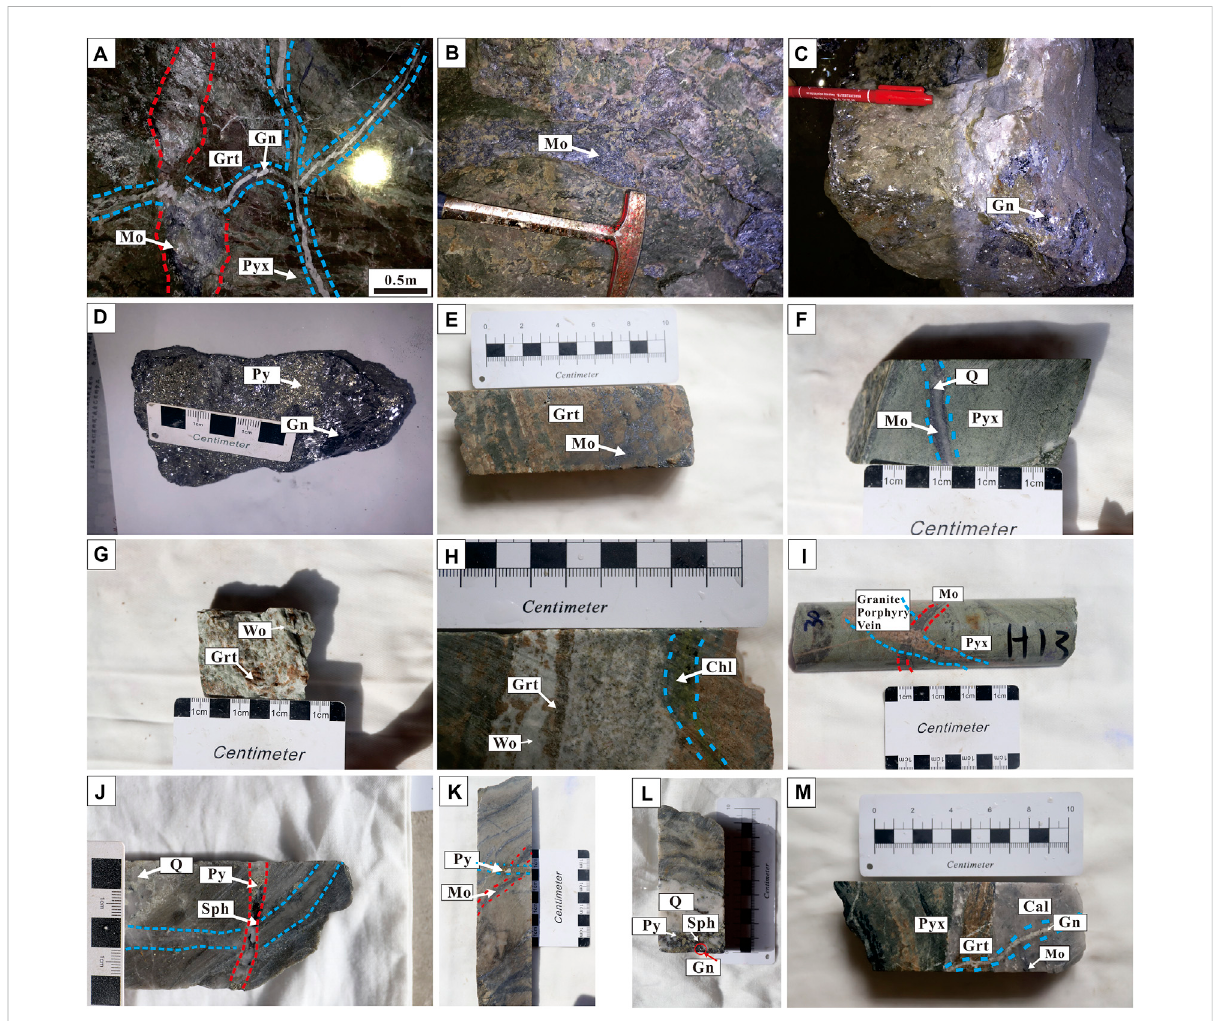
FIGURE 4 (A) Calcite – quartz vein cross-cutting a quartz – molybdenum – vein molybdenum; (B) molybdenum mineralization in skarn; (C) galena mineralization in the quartz – galena – sphalerite stage; (D) galena mineralization coexisting with pyrite in the quartz – galena – sphalerite stage; (E) molybdenum mineralization in garnet skarn; (F) molybdenum – quartz vein cross-cutting pyroxene skarn; (G) wollastonite skarn (Wo > Grt > Pyx); (H) chlorite alteration overprinting skarn; (I) dikes intrude into ore bodies; (J) galena – sphalerite – quartz vein cross-cutting molybdenum – quartz vein; (K) quartz – sul fi de vein cross-cutting molybdenum – quartz vein; (L) galena mineralization coexisting with sphalerite in the quartz – galena – sphalerite stage; and (M) calcite – quartz vein cross-cutting molybdenum – quartz vein and garnet skarn (Grt > Pyx). Chl = chlorite; Gn = galena; Grt = garnet; Mo = molybdenite; Py = pyrite; Pyx = pyroxene; Q = quartz; Sph = sphalerite; and Wo =